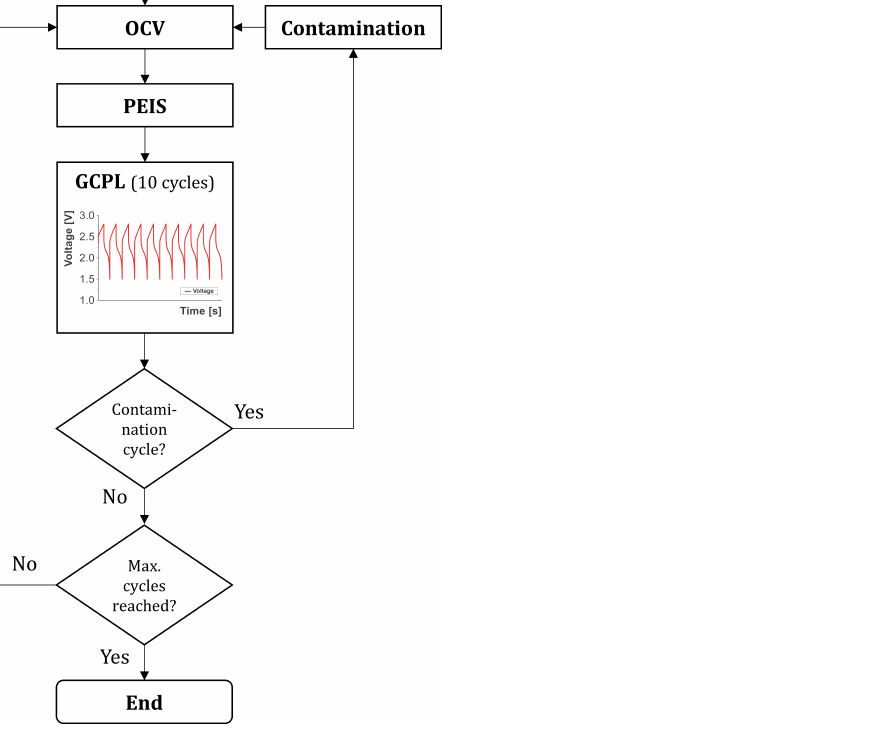
Figure 4. Test procedure for the specimen. OCV—open circuit voltage; PEIS—potentio electrochemi- cal impedance spectroscopy; GCPL—galvanostatic cycling with potential limitation between 1.5 V and 2.8 V consisting of 10 charge and discharge cycles (=1